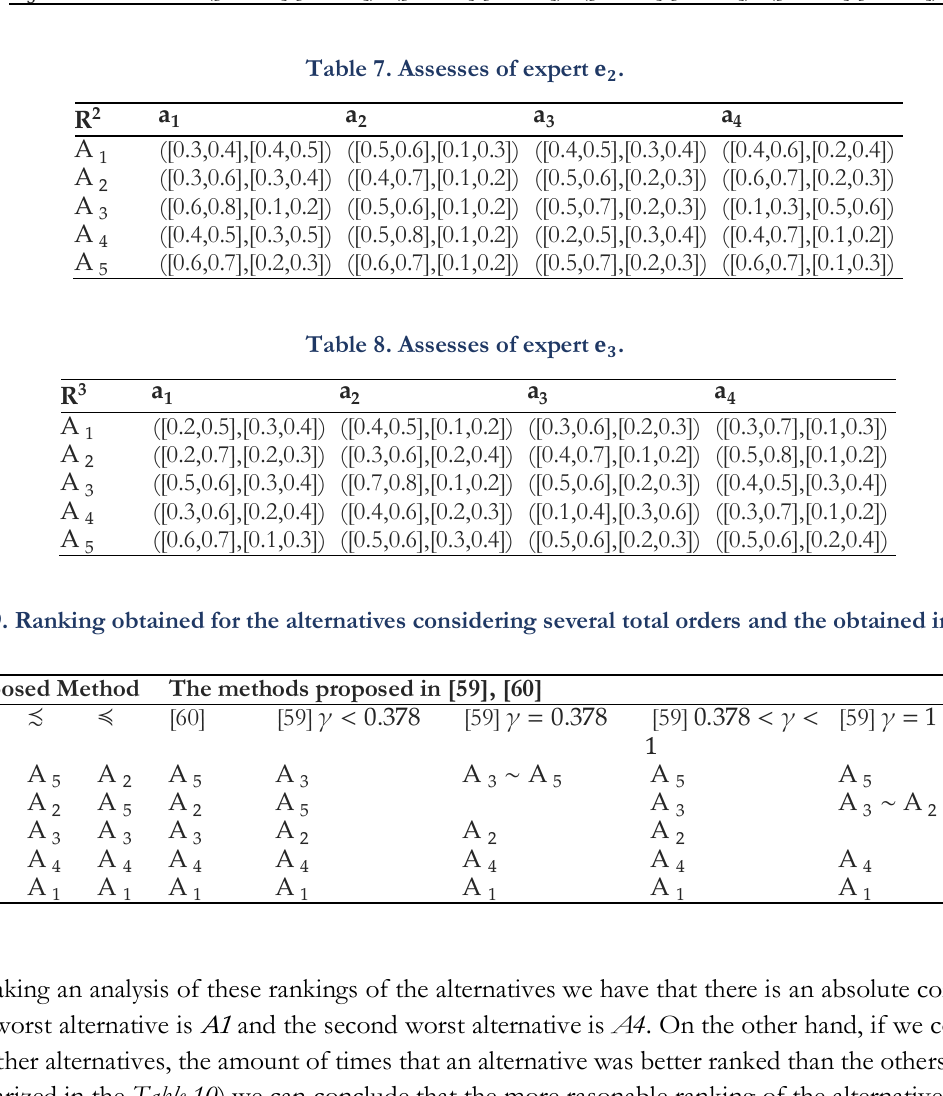
Table 7. Assesses of expert 𝐞